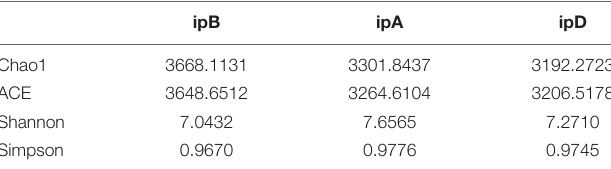
TABLE 2 | The mean values of different alpha diversity indices (Chao1, ACE, Shannon, Simpson) in the three groups.